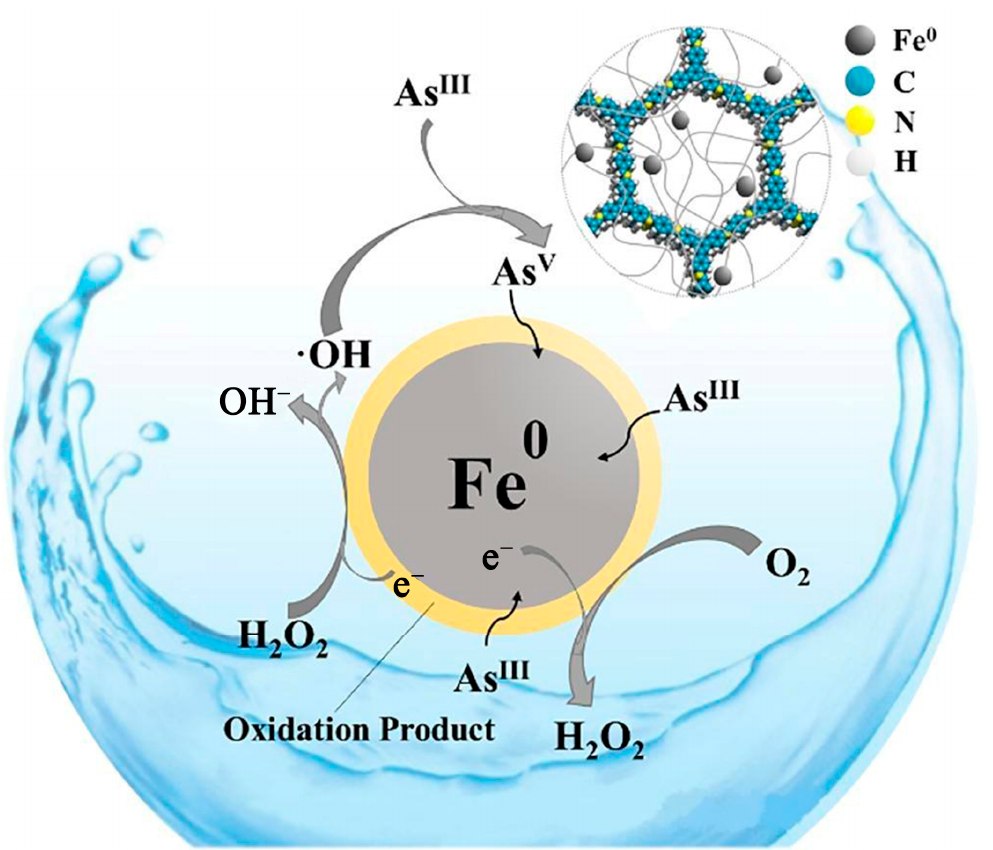
Figure 6. Schematic of proposed redox reactions on Fe 0 surface during As(III) adsorption processes